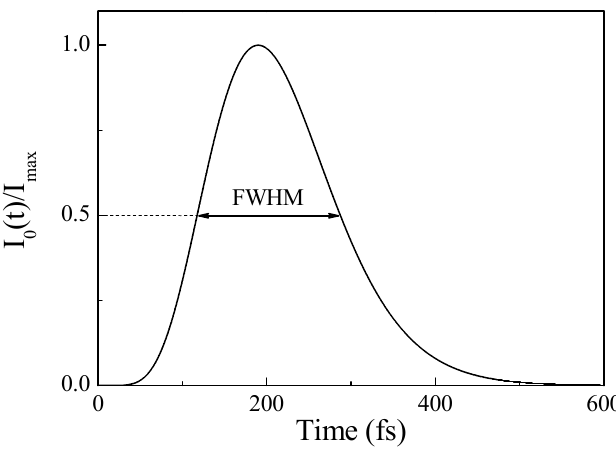
Figure 1. In this paper, the pulse time of the laser set as 170 fs.